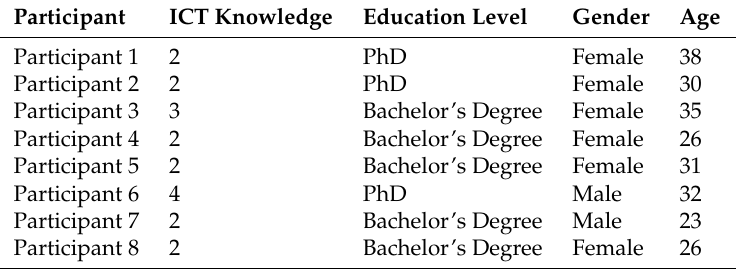
Table 2. Sociodemographic data of the participants of the focus group two. The ICTs Knowledge column represents the participant’s ability with the use of information and communication technologies. Zero means non-ICT knowledge and four denotes an expert